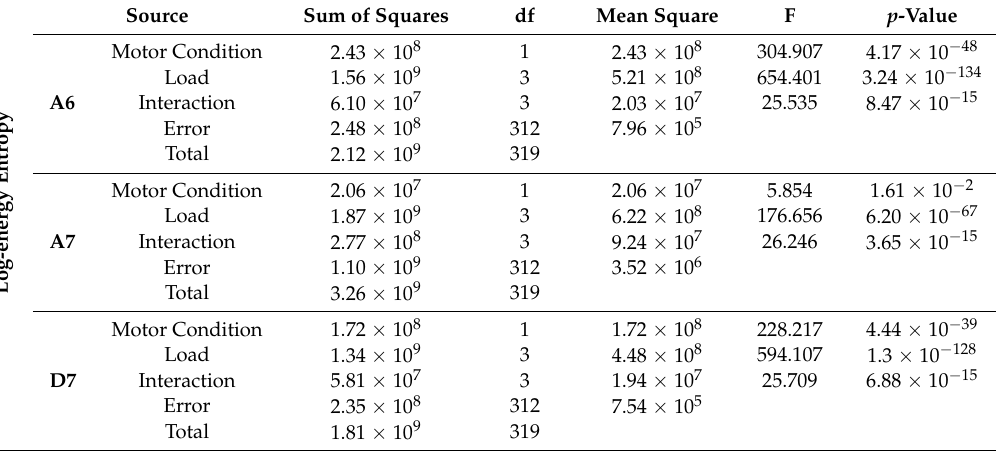
Table 4. Analysis of variance for log-energy entropy